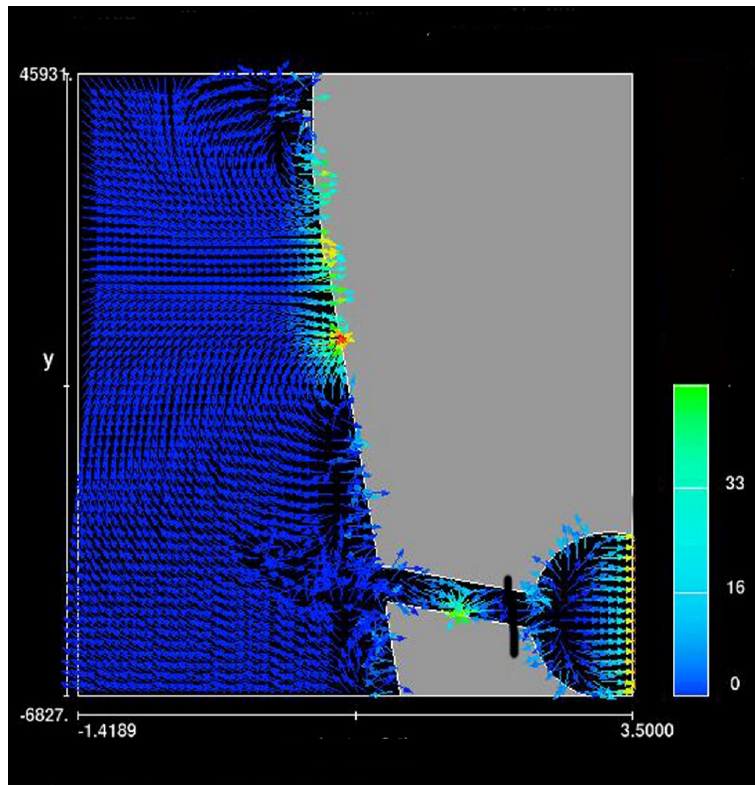
Figure 23. Velocity vector plot indicating turbulent flow at the Supe River outlet indicating the source of differential particle size sediment settling. Velocity scale is in ft/s; length scale is in km. For Figure 22, the density of the slurry stream is 5.2 times that of ocean water. Many beach ridges observed in the Santa–Viru sequence are composite, indicating large accu- mulations from multiple, closely-spaced-in-time flood events; where aggraded sediment material separates ridges, a longer time interval had occurred between major flood events: the use of C14 dating on organic material within the ridges then present the dating of ENSO flood events. Beach ridges contain mollusk shell material indicative of seabed sed- iments being agitated and entrained during flood events. Once the ridges are stranded on land by surrounding aggraded material, later flood events create new subsea deposits that accrete material to create the ridge sequence noted in the Santa–Viru coastal area, where shallow seabed angles prevail (Figure 23 and Figure 24 illustrates this occurrence). South of this zone, where steeper seabed angles prevail, a composite, a unitary ridge type is predicted. Situations occur in which loose surface sediment is minimal and/or the surface runoff water velocity too low to carry or erode sediment, so that ridge formation is mini- mal or absent during lower-magnitude flood events.